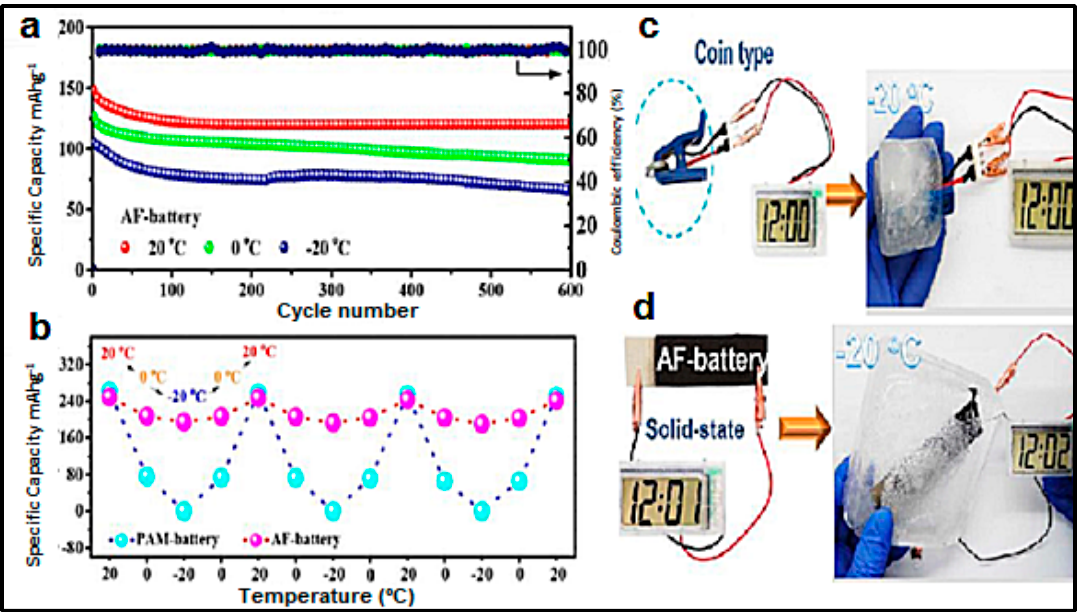
Figure 12. ( a ) Extended cycling performance at 2.4 Ag − 1 of the AF-battery at different temperatures. ( b ) Cyclic testing of PAM-battery and AF-battery under 20, 0, − 20 °C at 0.3 Ag − 1 . Battery in ice package. Freeze-resistant performance of the ( c ) coin-type and ( d ) solid-state flexible AF-batteries. Reproduced with permission from [160]. Copyright 2019 Royal Society of Chemistry.